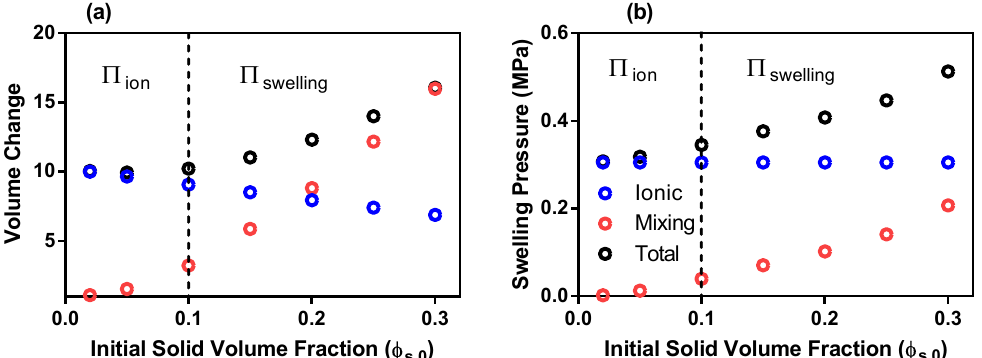
Figure 3. Divalent Solution: ( a ) Equilibrium volume change of the ionic, mixing and total swelling pressures as a function of initial solid volume fraction ( b ) Initial swelling pressures of ionic, mixing and total swelling energies as a function of initial solid volume fraction. [ Π ion and Π swelling keys denote the swelling pressure model that should be used at each initial solid volume fraction].